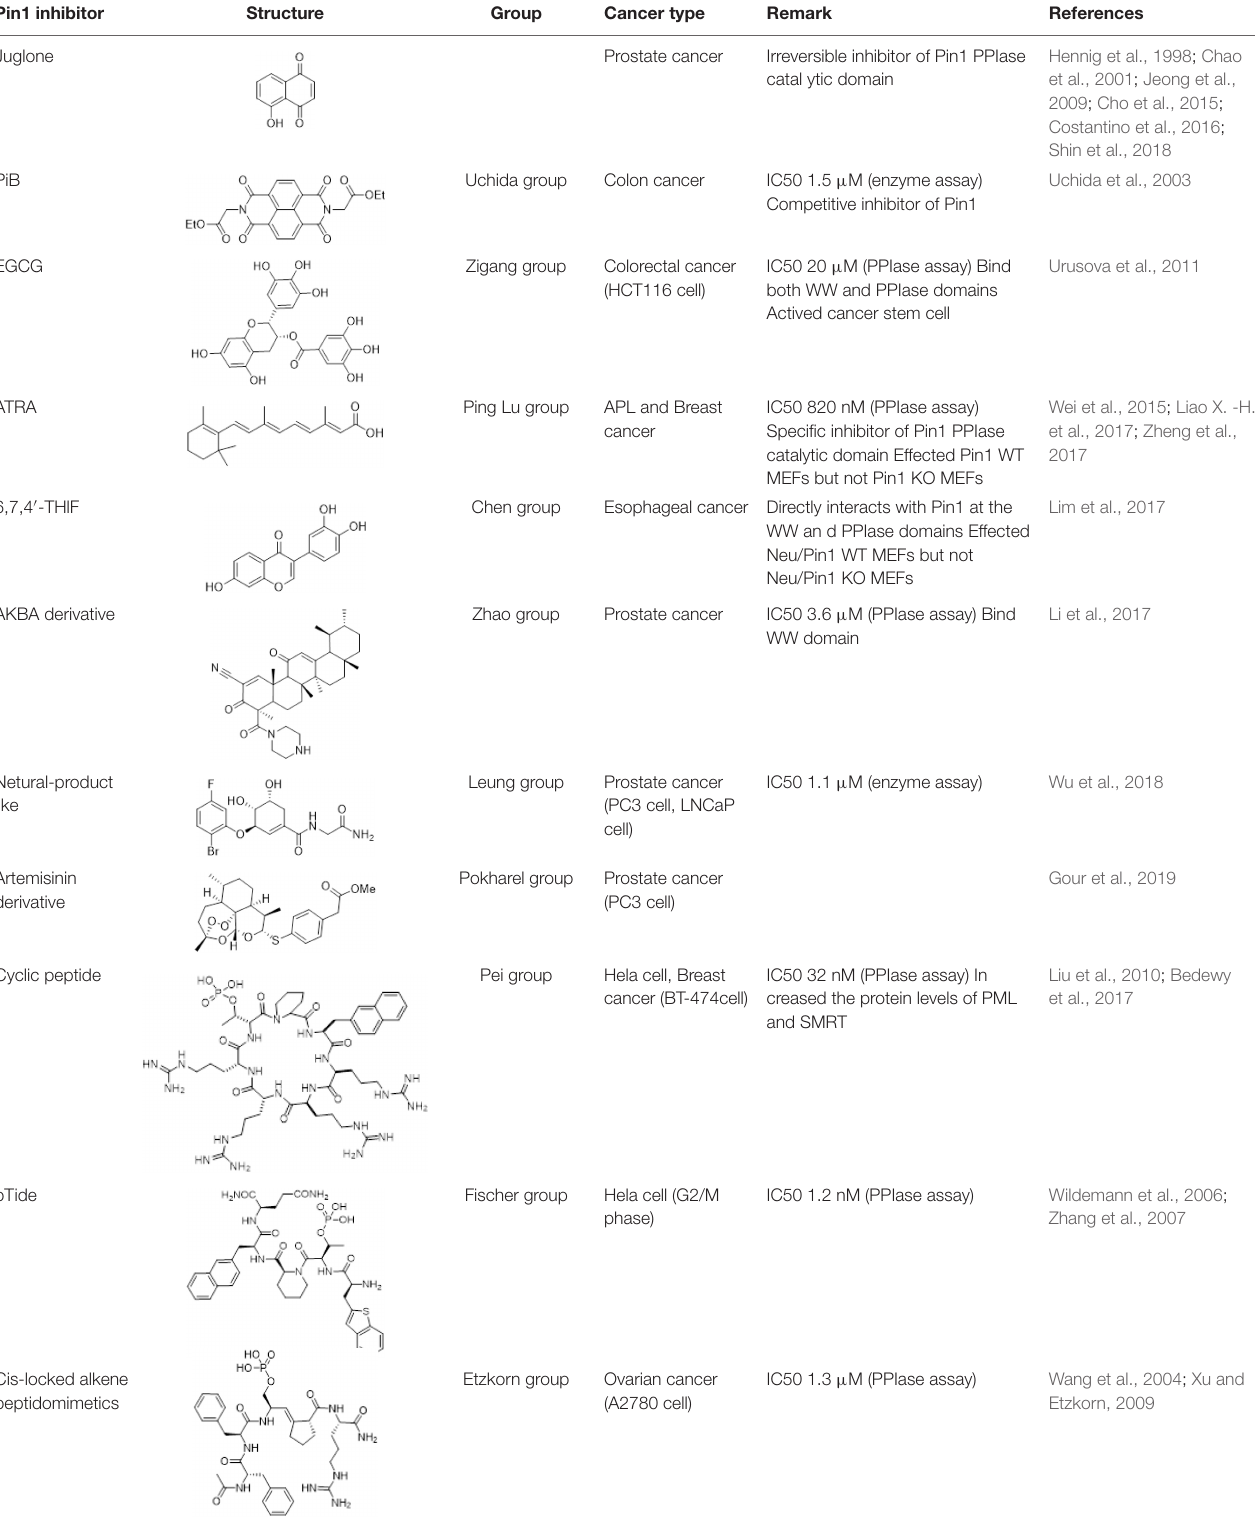
TABLE 1 | PIN1 inhibitors for cancer